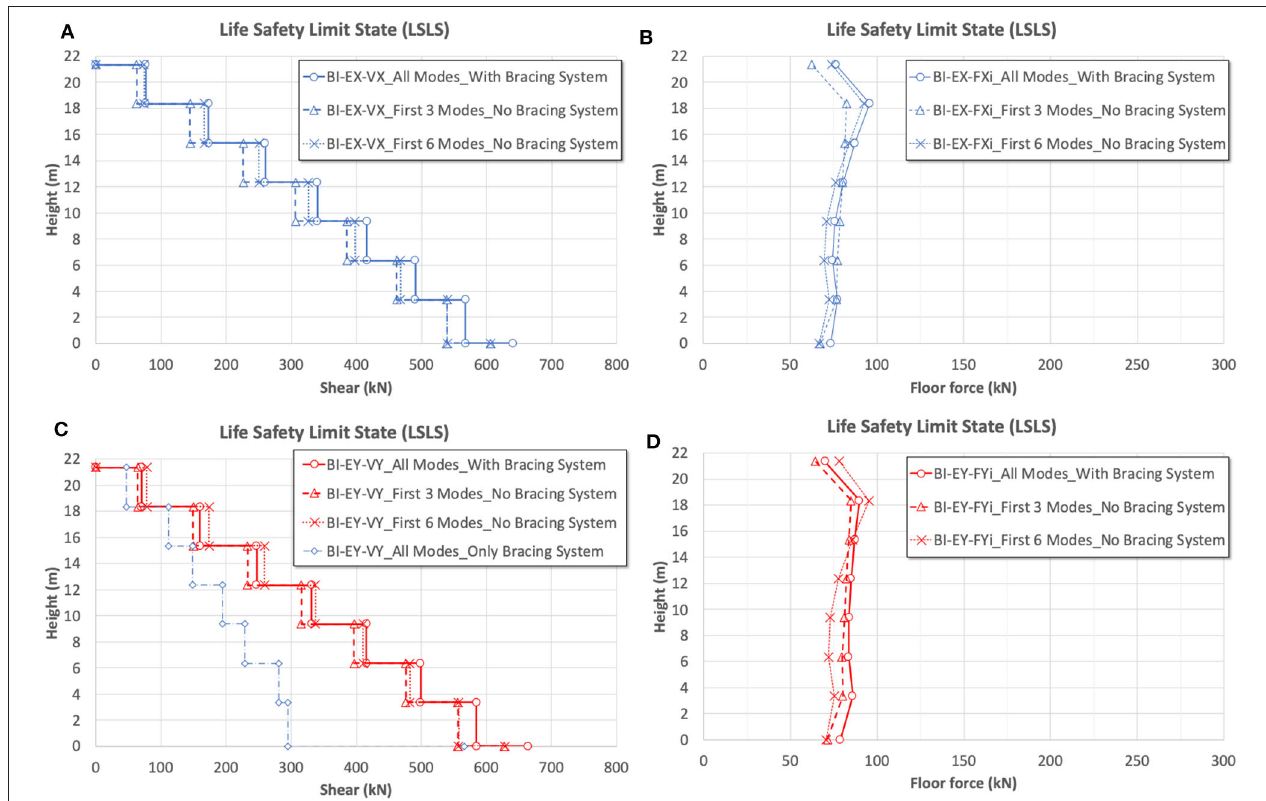
FIGURE 10 | BI model LSLS results. Shears and forces acting at each floor building. (A,B) Shear and floor forces acting along X, and (C,D) along Y direction.